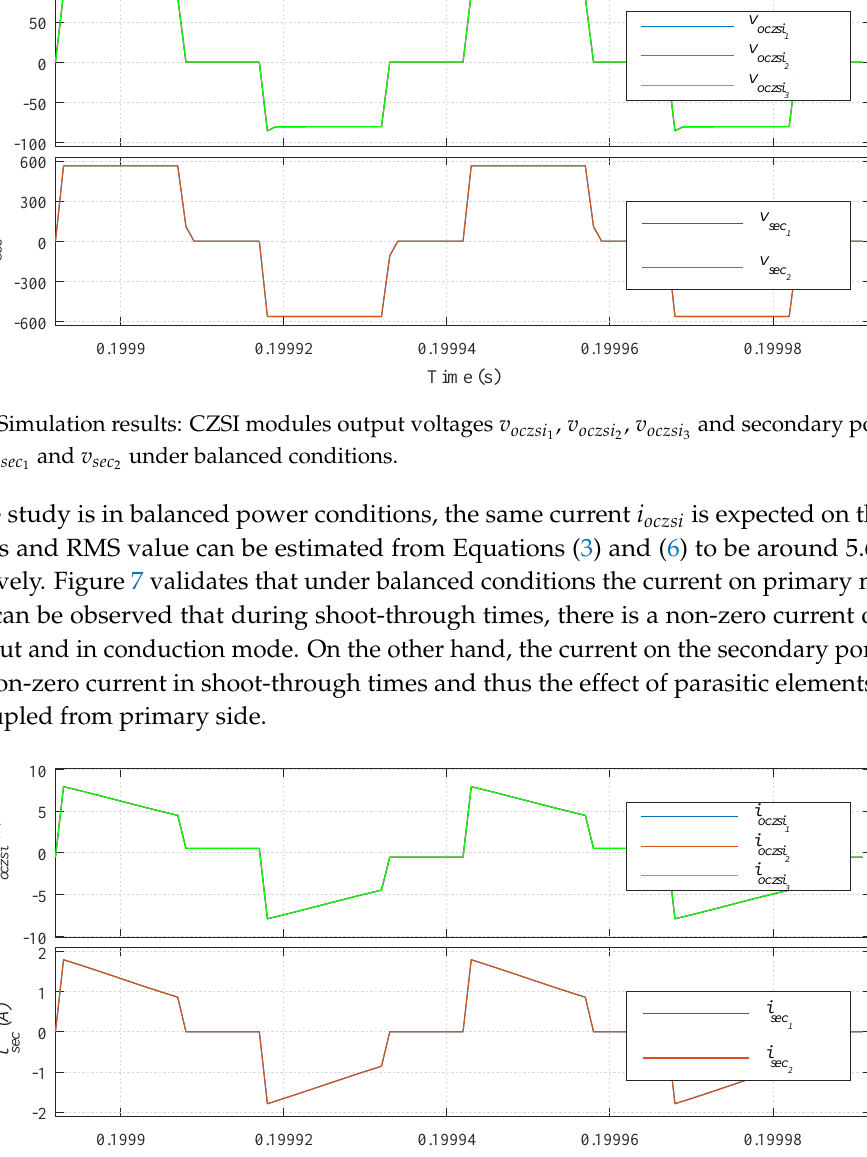
, i oczsi , i oczsi and secondary ports 2 3 1